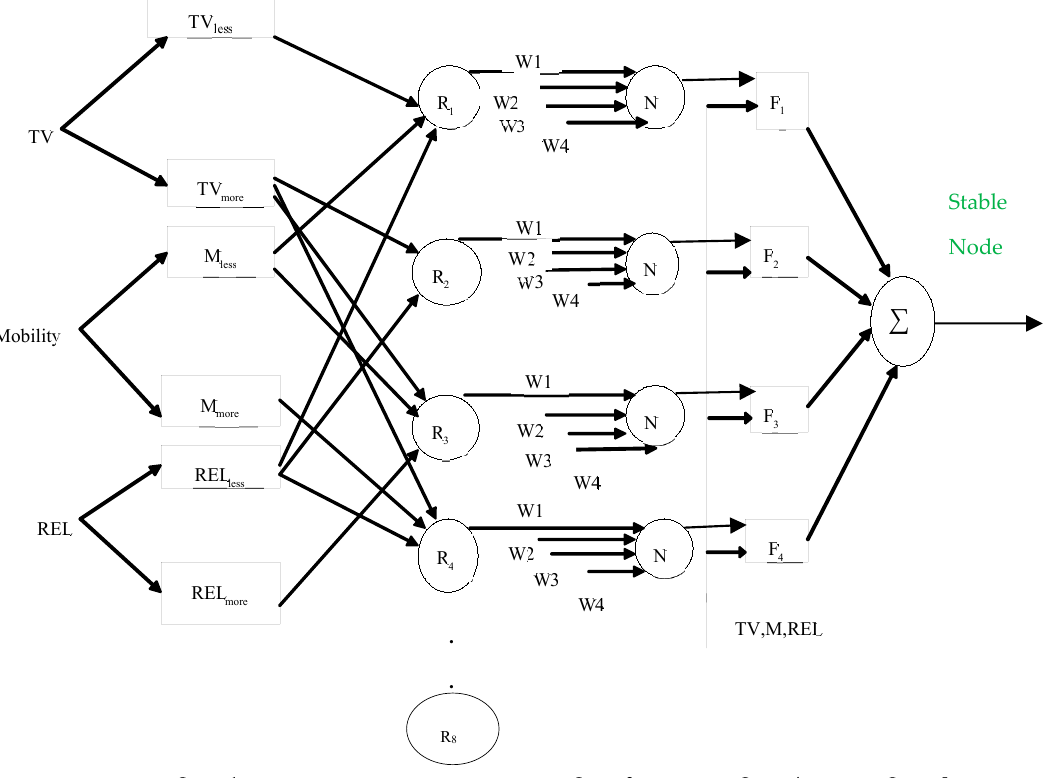
Figure 1. ANFIS-Based, Energy-Efficient Secure Clustering Model.